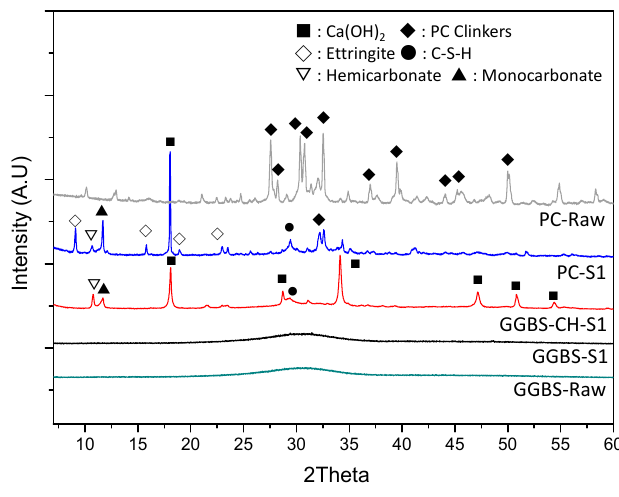
Figure 5. XRD patterns for raw materials (PC and GGBS), PC-S1, GGBS-CH-S1, and GGBS-S1.